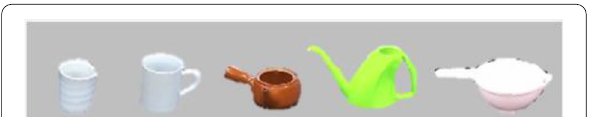
Fig. 6 Example of object used in this experiment